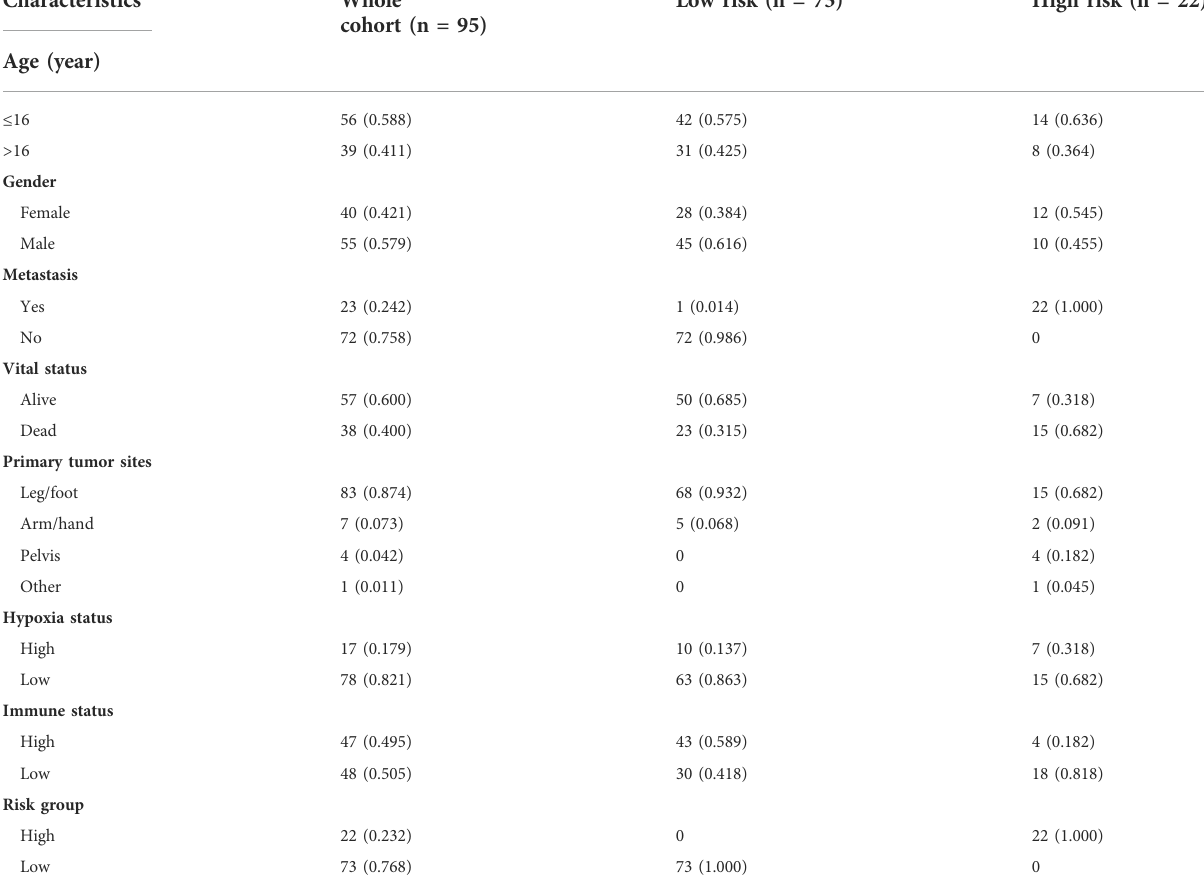
TABLE 2 The clinical information of osteosarcoma patients in the training cohort from TARGET database.